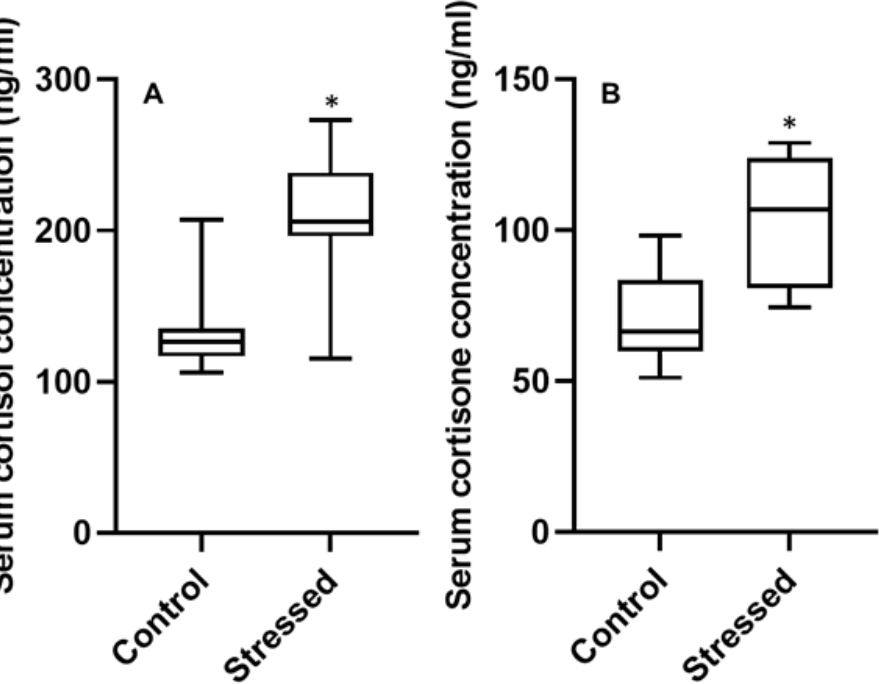
range of the data. Asterisks indicate significant difference from control ( p < 0.01; n = 14).